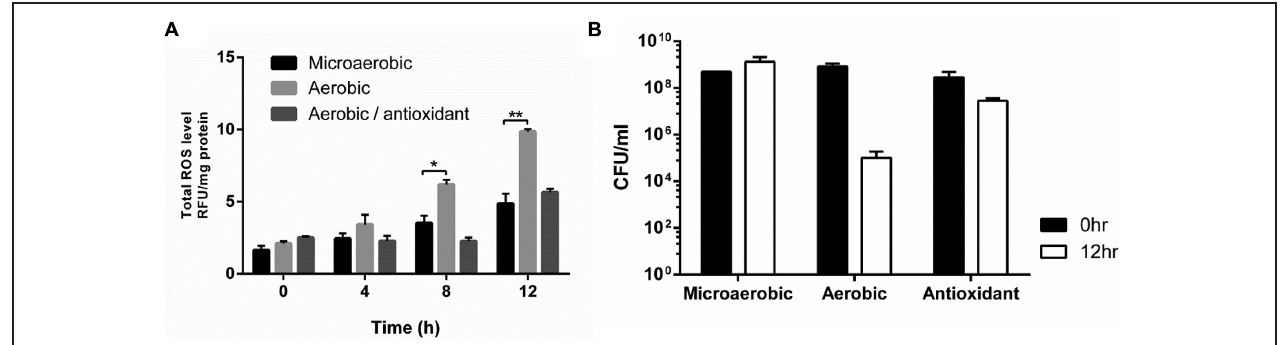
FIGURE 1 | Total reactive oxygen species (ROS) accumulation (A) and Campylobacter jejuni viability (B) under microaerobic and aerobic conditions. N -acetyl cysteine was used as an antioxidant to a final concentration of 1 nM. The results show the means and SD of triplicate samples